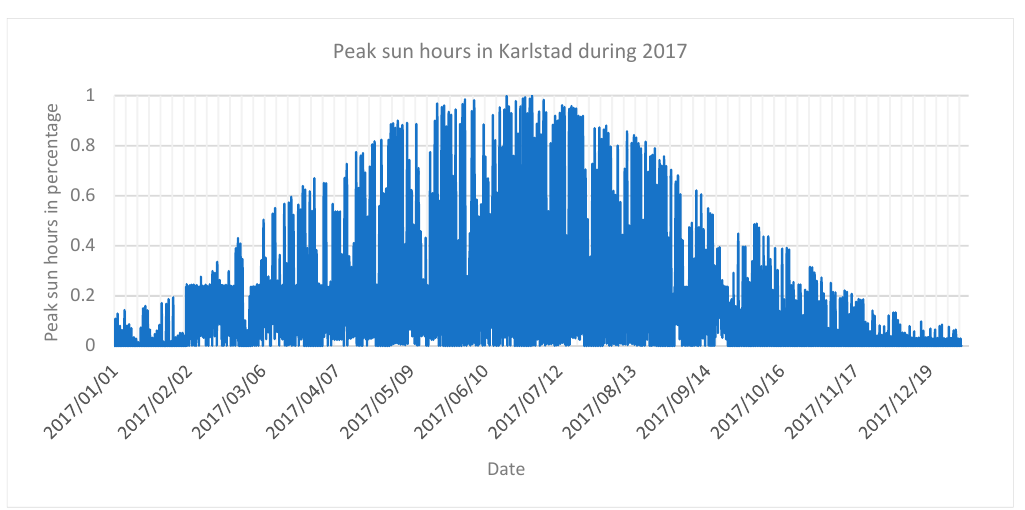
Figure 6. Peak sun hours in Karlstad during 2017 [19].